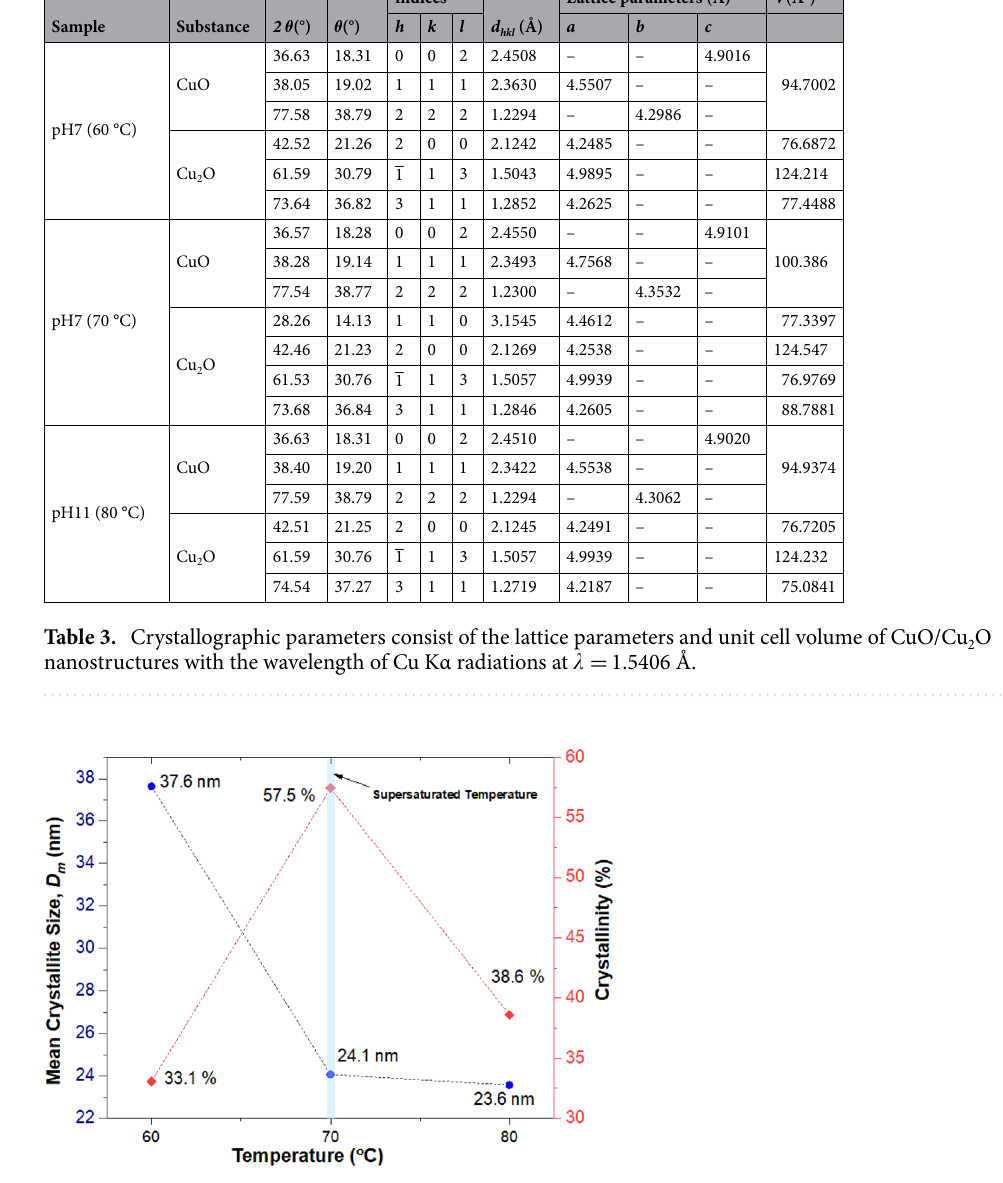
Figure 9. The mean crystallite size, D m and percentage crystallinity calculated from XRD